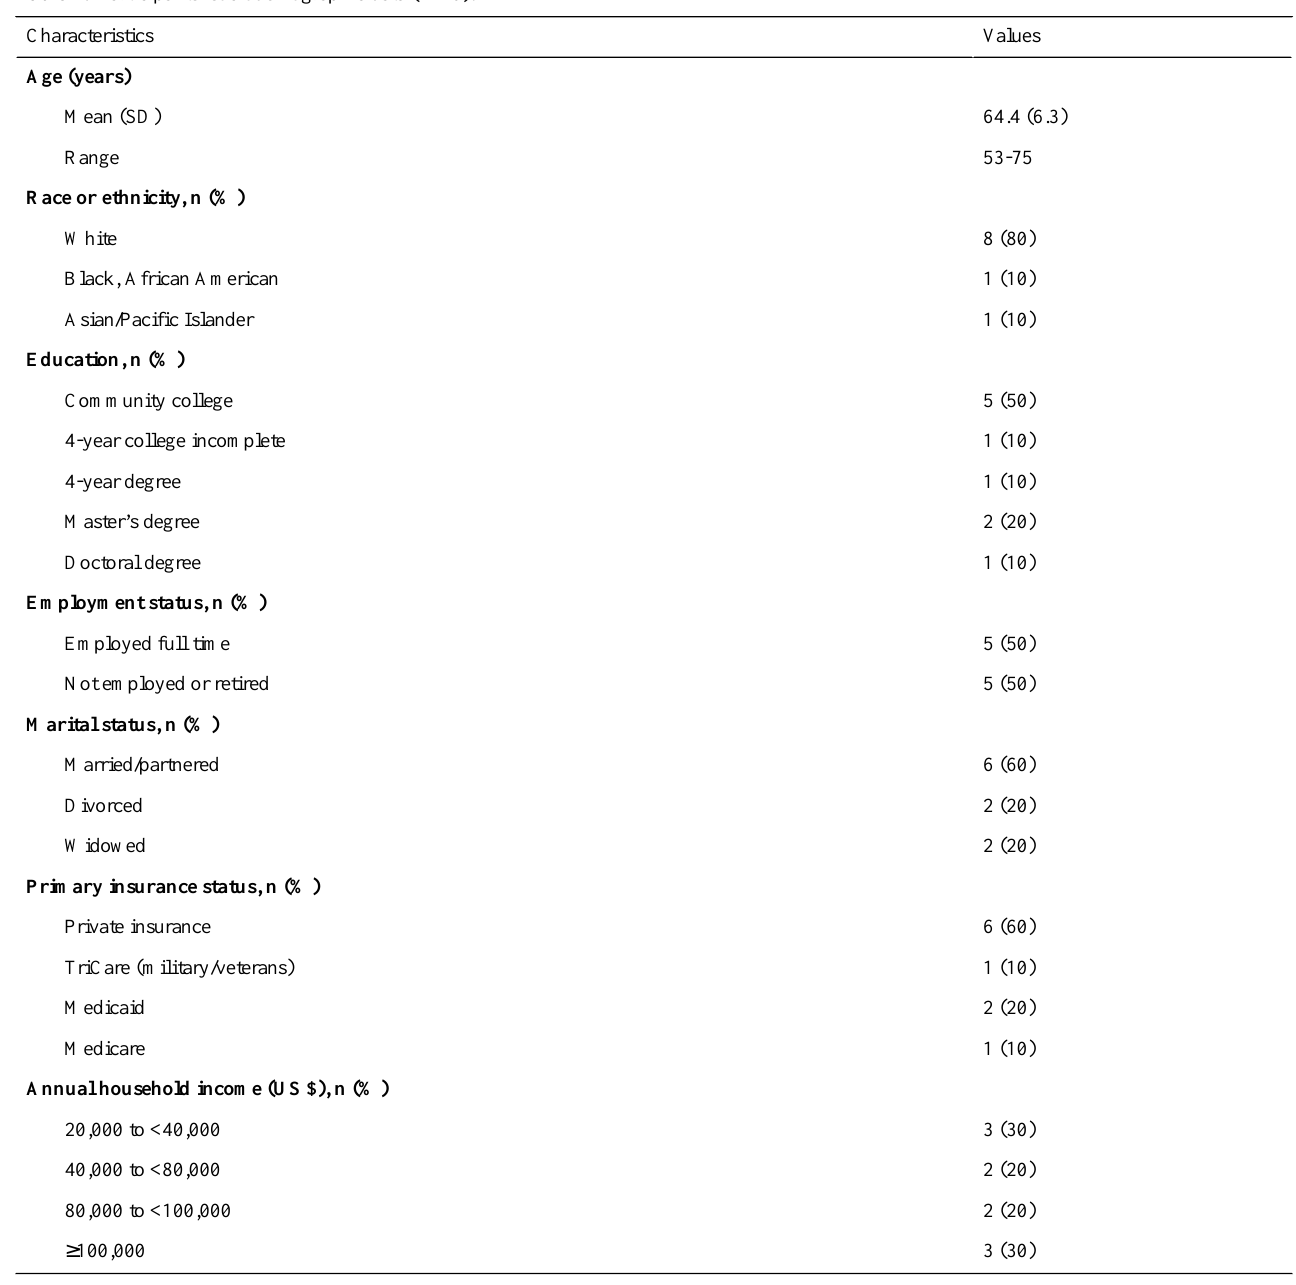
Table 1. Participants’sociodemographic data